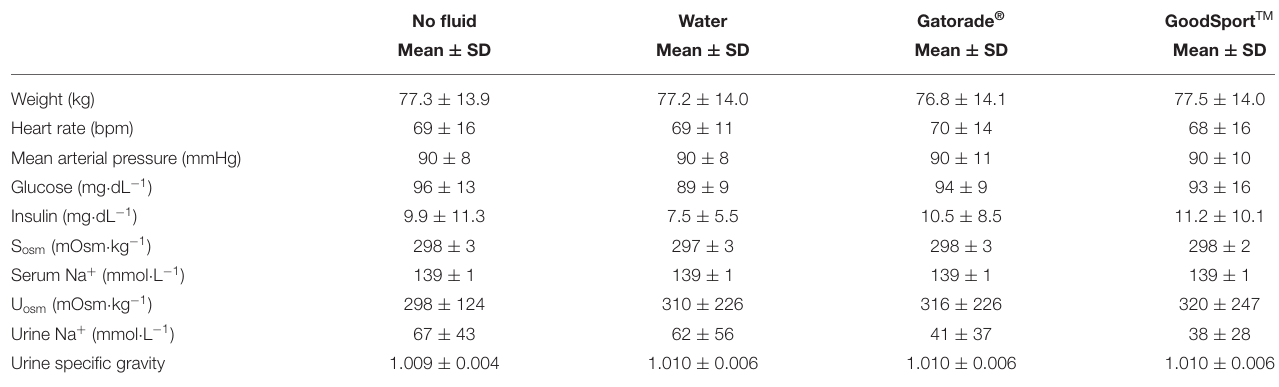
TABLE 3 | Baseline characteristics by trial.